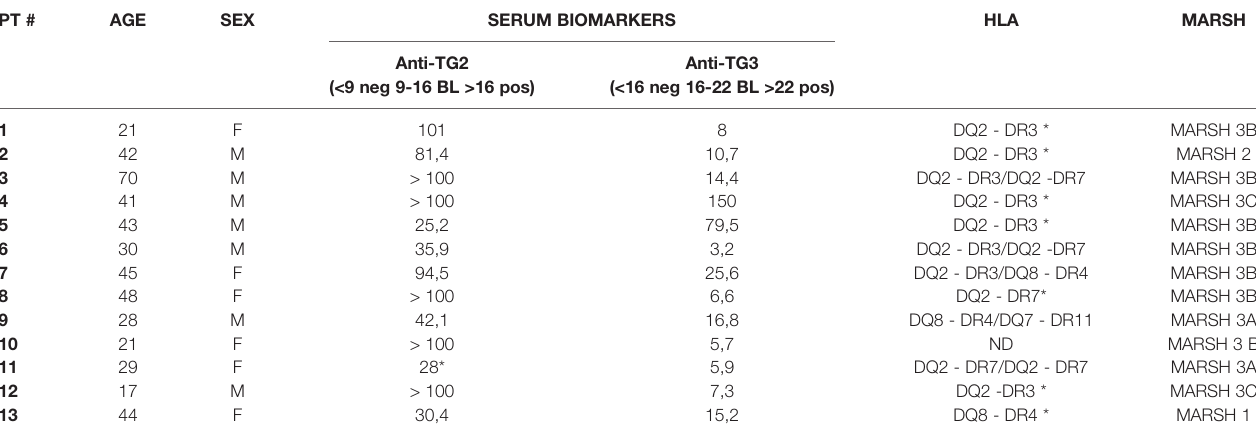
TABLE 2 | Clinical features of CD patients without